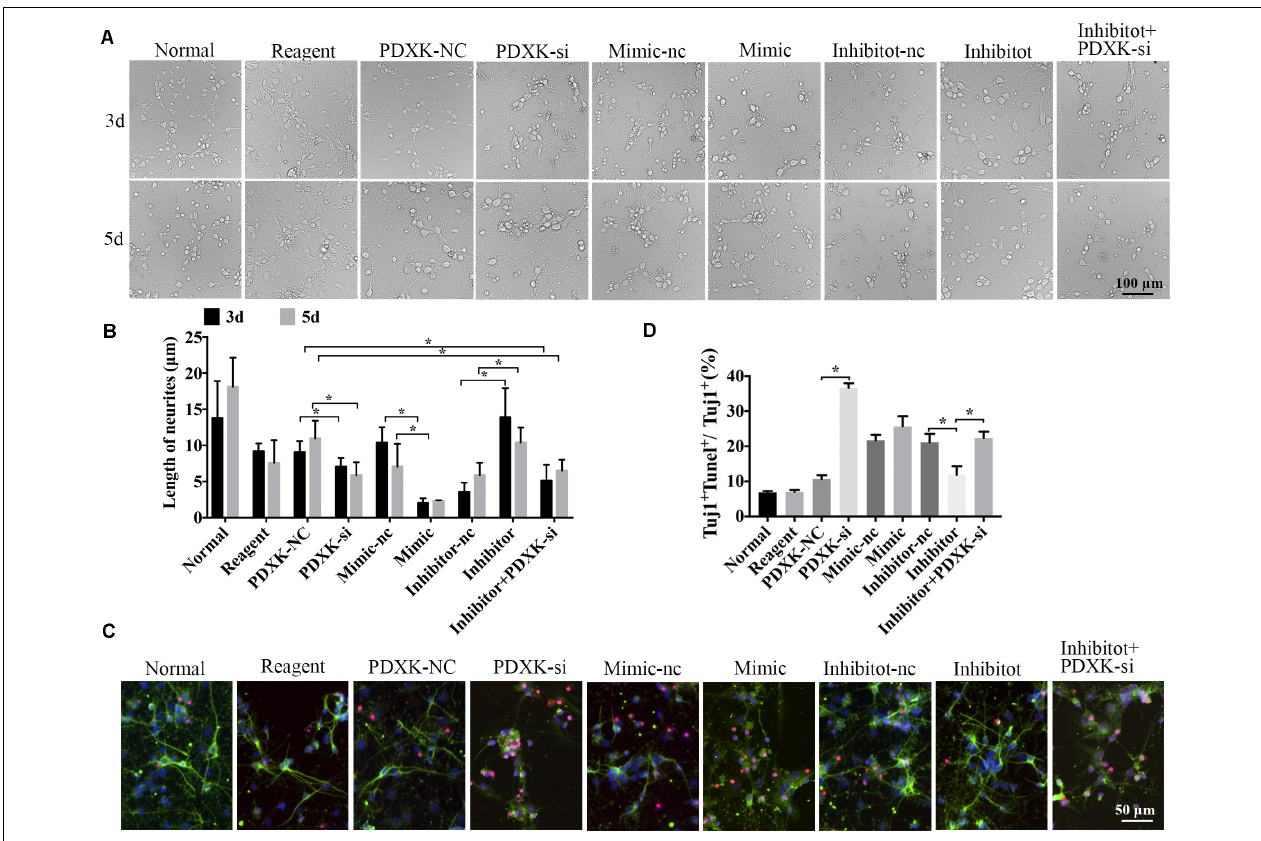
FIGURE 5 | The role of miR-339 on neurite growth. (A) The cell physiological status under different situation in normal, reagent, NC, mimic-NC, inhibitor-NC, mimic, inhibitor, PDXK-si, and inhibitor + PDXK-si groups on 3 and 5 days after transfection. Scale bar = 100 µ m. (B) Quantitative results of the length of neurites in normal, reagent, NC, mimic-NC, inhibitor-NC, mimic, inhibitor, PDXK-si, inhibitor + PDXK-si groups at 3 and 5 days post-transfection. (C) Evaluation of apoptotic cortical neurons by Tuj1 immunofluorescent staining and TUNEL staining, presented by Tuj1 + Tunel + /Tuj1 + (%) in normal, reagent, NC, mimic-NC, inhibitor-NC, mimic, inhibitor, PDXK-si, inhibitor + PDXK-si groups. DAPI counterstaining (blue) shows nuclei of intact cells, green fluorescence represented Tuj1 + , and red fluorescence represented apoptosis. Scale bar = 50 µ m. (D) Quantitative analysis for neuronal apoptosis, presented by Tuj1 + Tunel + /Tuj1 + (%) in normal, reagent, NC, mimic-NC, inhibitor-NC, mimic, inhibitor, and PDXK-si, inhibitor + PDXK-si groups. Data were exhibited as mean ± SD; * P < 0.05. PDXK, pyridoxal kinase; NC, negative control; PDXK-si, PDXK interference; TUNEL, terminal deoxyribonucleotidyl transferase-mediated dUTP-digoxigenin nick-end labeling; DAPI,